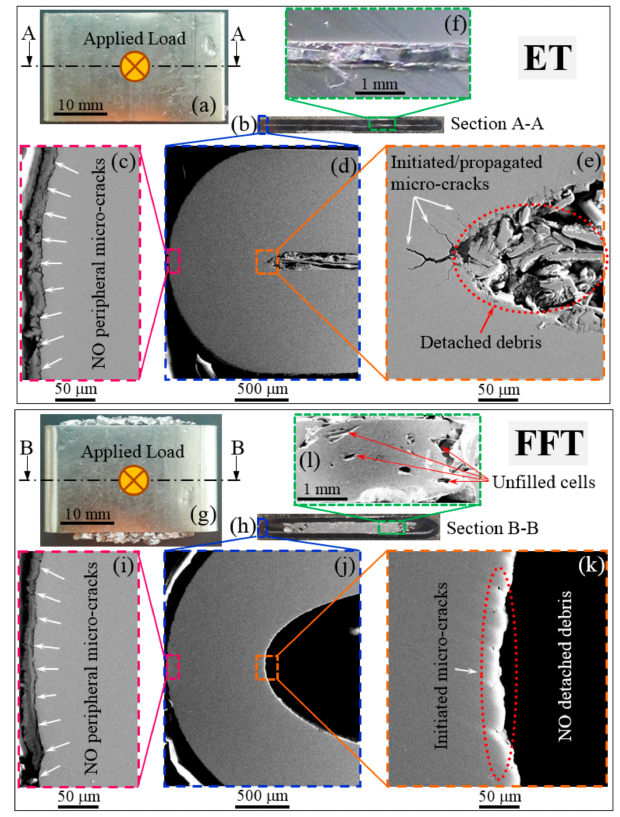
Figure 4. Macroscopic ( a , b , f , g , h , l ) and microscopic ( c – e , i – k ) images of initiated and propagated micro-cracks in ETs and FFTs